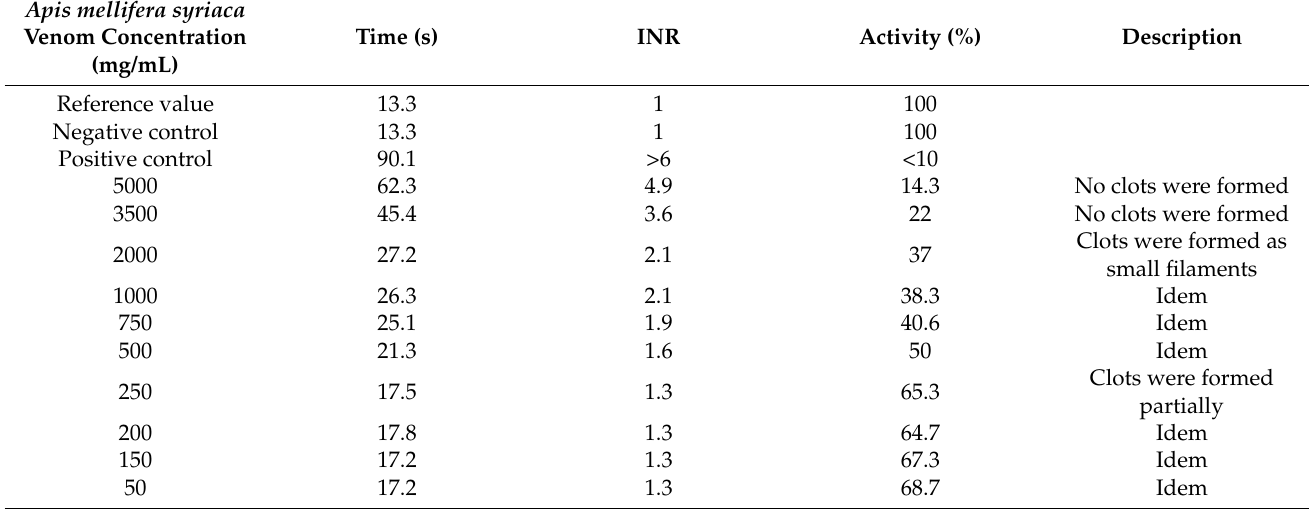
Table 1. PT test values for different A. mellifera syriaca venom